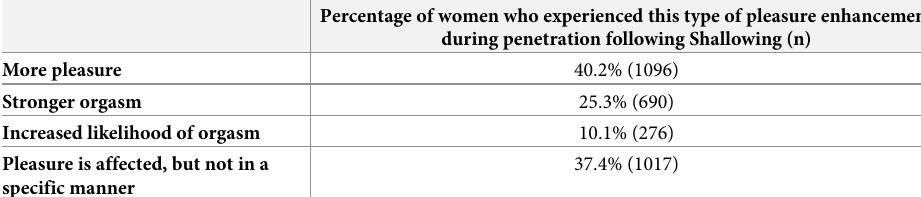
Table 5. Prevalence of specific types of pleasure enhancement experienced by women during vaginal penetration following Shallowing (N = 2723, weighted).